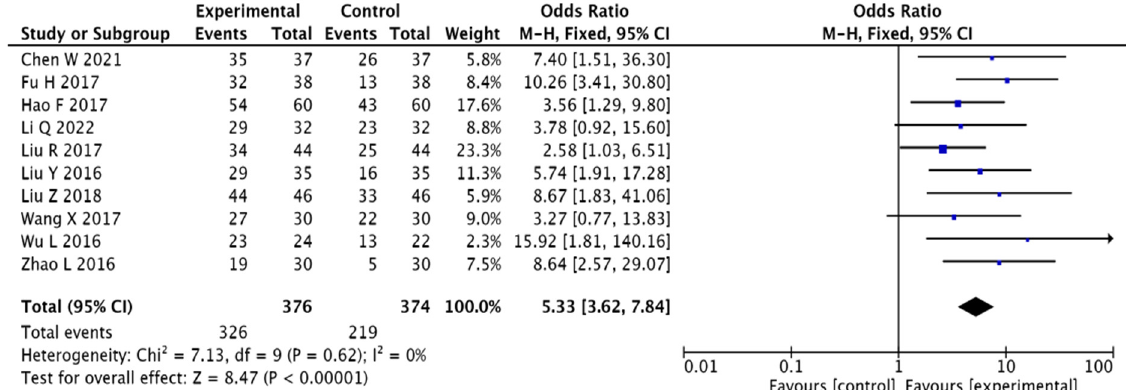
Figure 4. Forest diagram with efficiency comparisons [13,14,18,20–26].